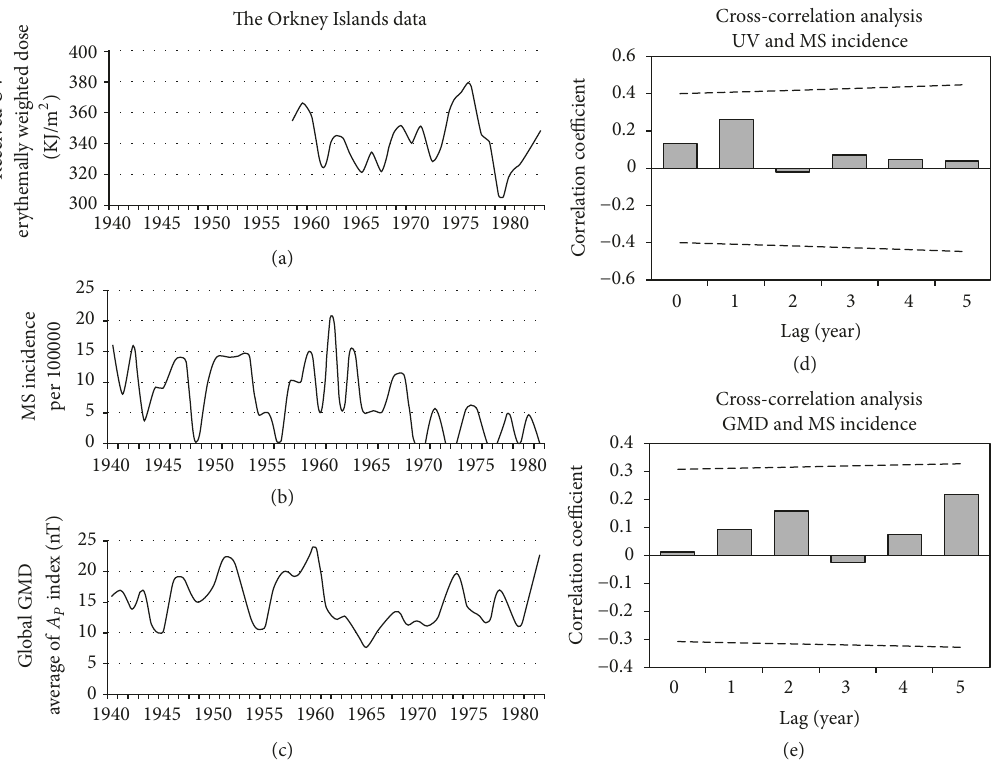
Figure 3: The Orkney Islands data. Panel (a): annual average of the received UV (1958–82). Panel (b): MS incidence of the Orkney Islands (1941–82), adapted from the report of Cook et al. [12]. Panel (c): annual average of global GMD based on the 𝐴 𝑝 index (1941–82). Panel (d): the result of lagged correlation between received UV and MS incidence. Panel (e): the result of lagged correlation between GMD and MS incidence. The dashed lines in those panels (d and e) are the threshold for significant correlation. The horizontal solid lines in these panels indicate coefficient of correlation (𝑟) = 0